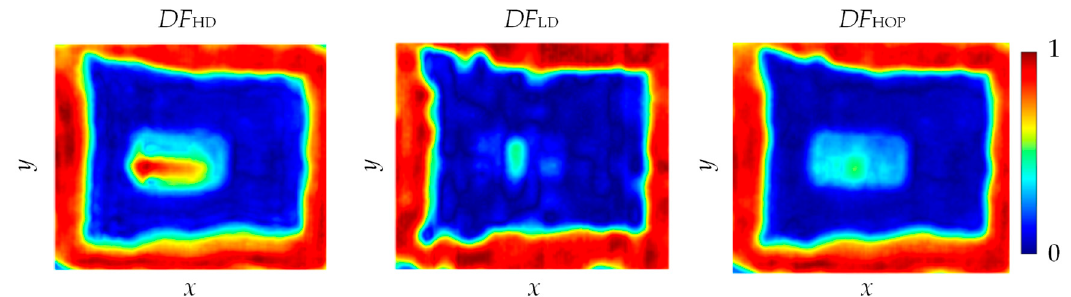
Figure 19. Multi-source data integration results obtained for higher depths ( DF HD ) and lower depths ( DF LD ) and hybrid opinion pooling DF HOP .